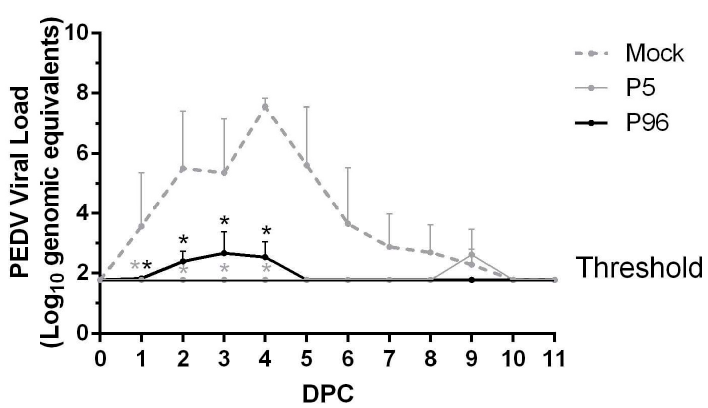
Figure 7. Fecal shedding of porcine epidemic diarrhea virus (PEDV) in PEDV strain Pintung 52 (PEDVPT)-P5- or PEDVPT-P96-inoculated pigs following PEDVPT-P5 challenge. Changes in the mean values GE/mL are shown as log 10 values ± SEM. The threshold indicates the limitation of detection by the SYBR Green-based RT-PCR. The black, gray, and dashed lines illustrate the results for the PEDVPT-P96-inoculated group, PEDVPT-P5-inoculated group, and mock-infected group, respectively. *: significant difference in the mock group ( p < 0.05).